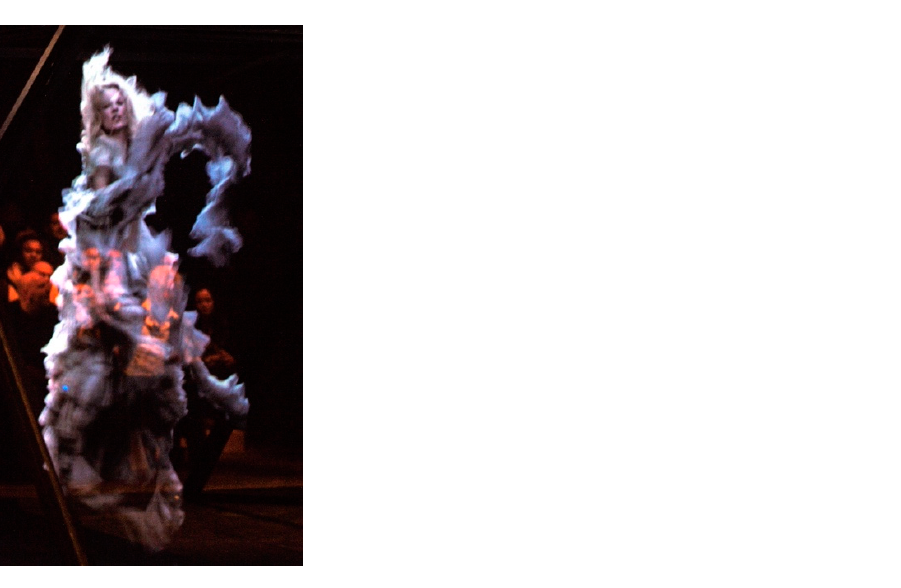
Figure 7. “Holographic” (actually Pepper’s Ghost) model in 2006 Alexander McQueen show. (Photo ©FirstVIEW/IMAXtree.com, used with permission.)